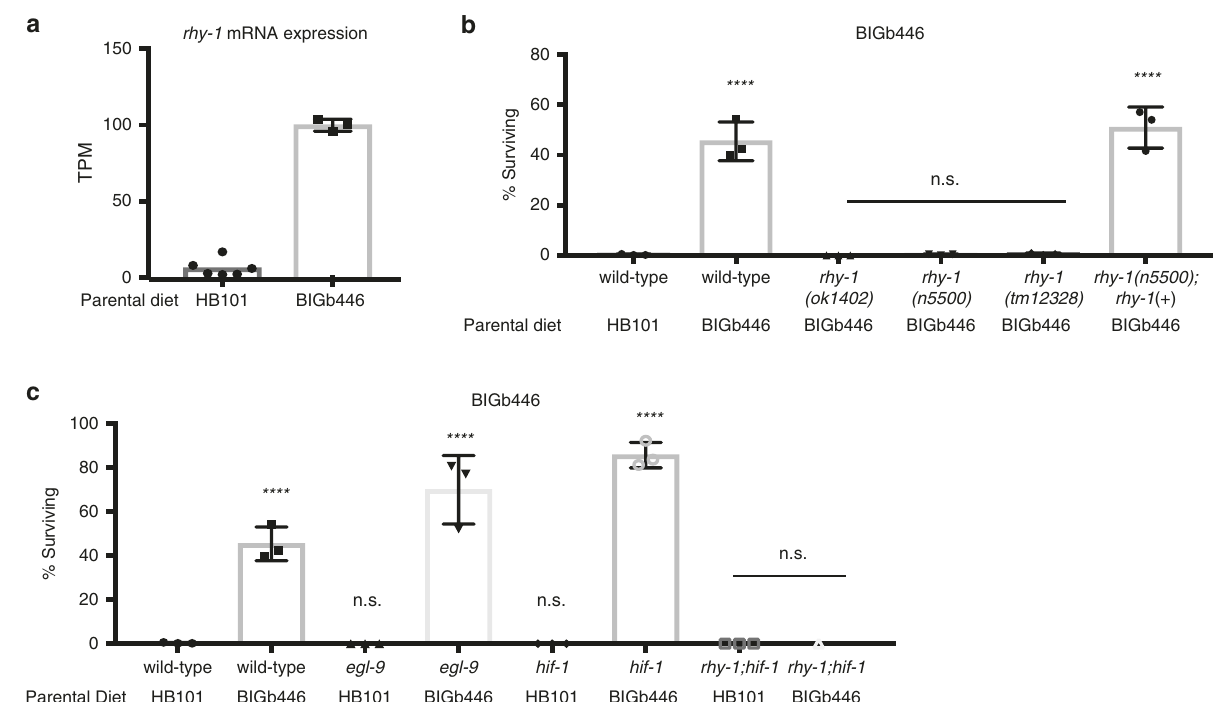
Fig. 5 RHY-1 is required for C. elegans adaptation to P. vranovensis . a Transcripts per million (TPM) of rhy-1 in wild-type embryos from parents fed E. coli HB101 or P. vraonvensis BIGb446. Data presented as mean values±s.d. n = 3 – 6 replicates. b Percent of wild-type and rhy-1 mutants surviving on plates seeded with bacterial isolates BIGb446 after 24h. Data presented as mean values±s.d. n = 3 experiments of >100 animals. c Percent of wild-type, egl-9(n586), hif-1 (ia4) , and rhy-1(n5500) mutants surviving on plates seeded with bacterial isolates BIGb446 after 24h. Data presented as mean values±s.d. n = 3 experiments of >100 animals. **** p <0.0001. Source data are provided as a Source Data fi le. See section “ Statistics and reproducibility ” for statistical tests run.